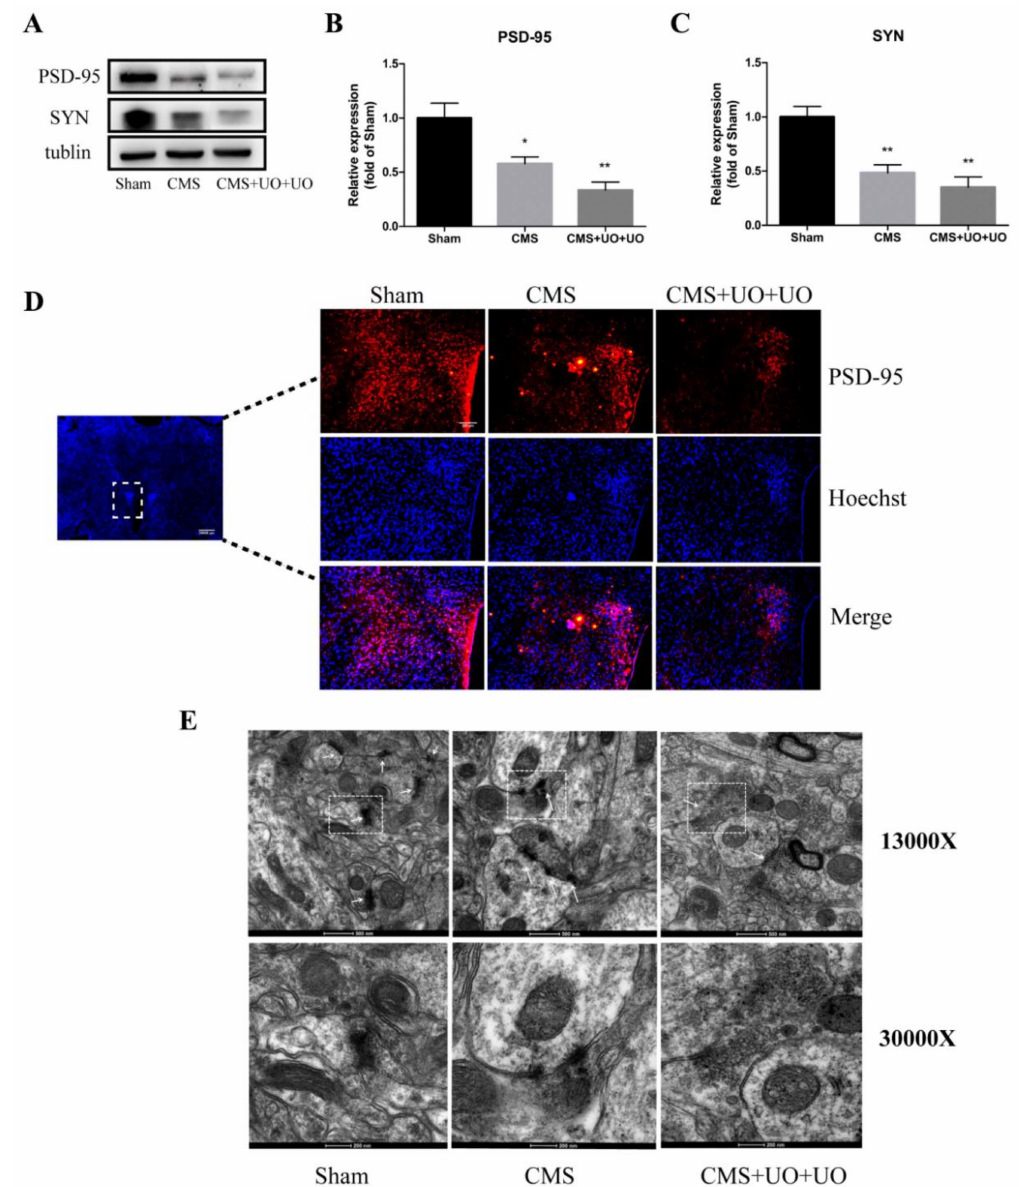
Figure 5. Hypothalamic synaptic plasticity injury in peri / postmenopausal depressive model mice. ( A – D ) The expression of synaptic proteins (PSD-95) and synaptophysin in the PVN in the sham, CMS, and CMS + UO + UO groups was detected by western blot and Immunofluorescence (IF). ( E ) The morphologies of synaptic structure in the hypothalamus in the sham, CMS, and CMS + UO + UO groups were detected by transmission electron microscope. Data are presented as means ± SEMs, n = 4–5, * p < 0.05, ** p < 0.01 versus